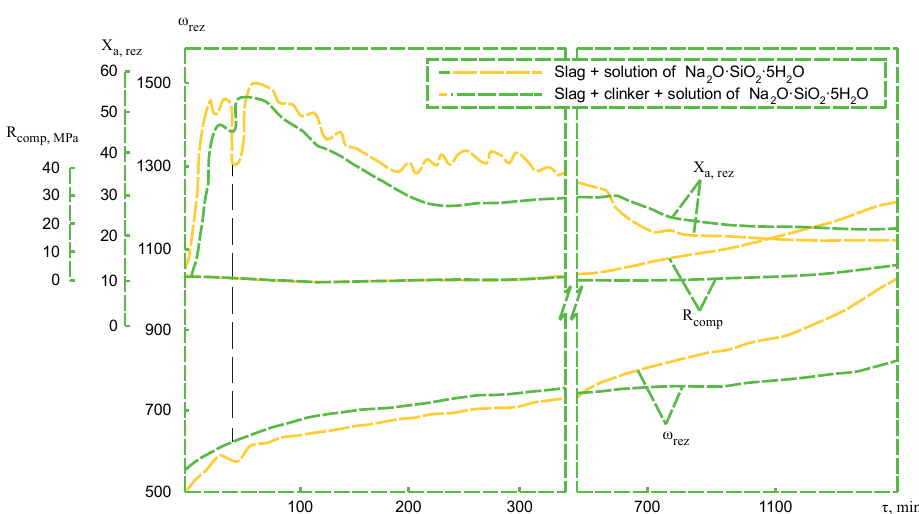
Figure 3. The influence of the additive (Portland cement clinker) on the structure formation process at temperature of 20 ◦ С.